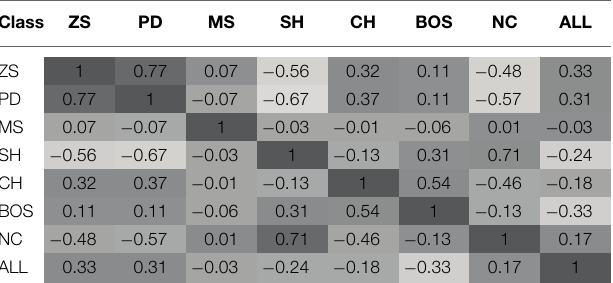
TABLE 3 | Spearman rank correlation of agents’ behavior by training